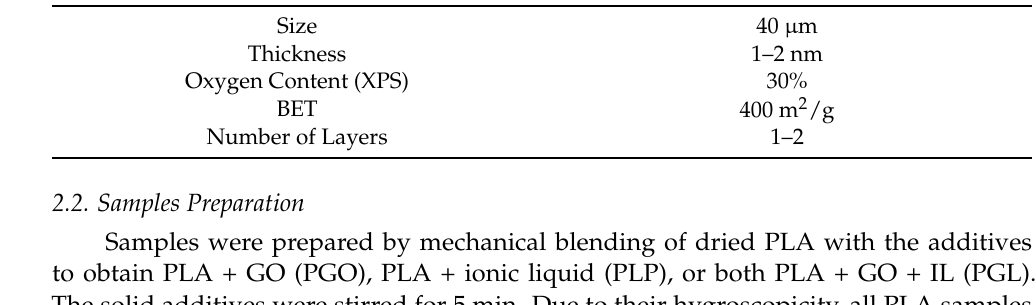
Figure 1. Chemical structure of Poly-lactic acid (PLA) ( a ) and ionic liquid (IL) ( b ). Table 1. Technical information of graphene